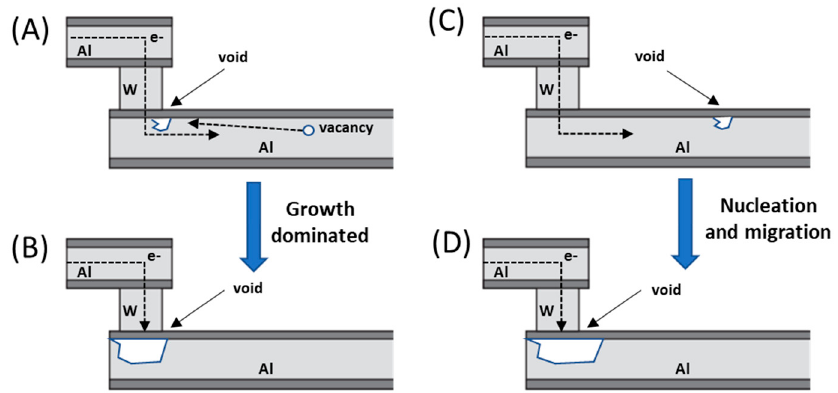
Figure 1. Two different mechanisms of void formation in copper during electromigration stress for ( A ) and ( B ) which is due to growth dominated failure, and ( C ) and ( D ) which corresponds to nucleation and migration.